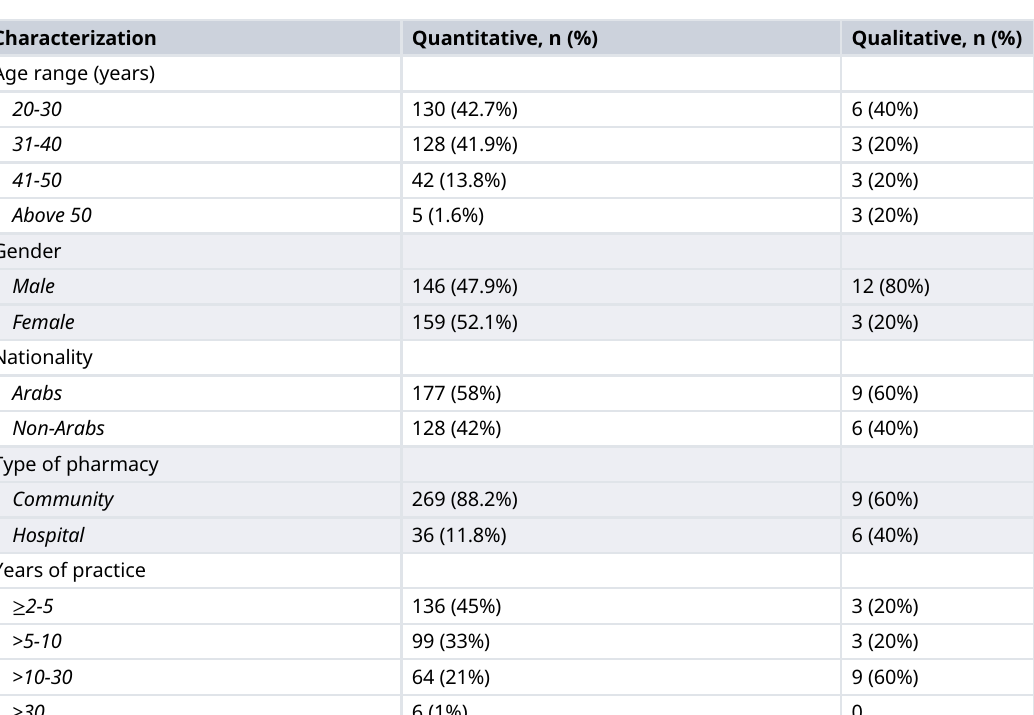
Table 1. Demographic profile of